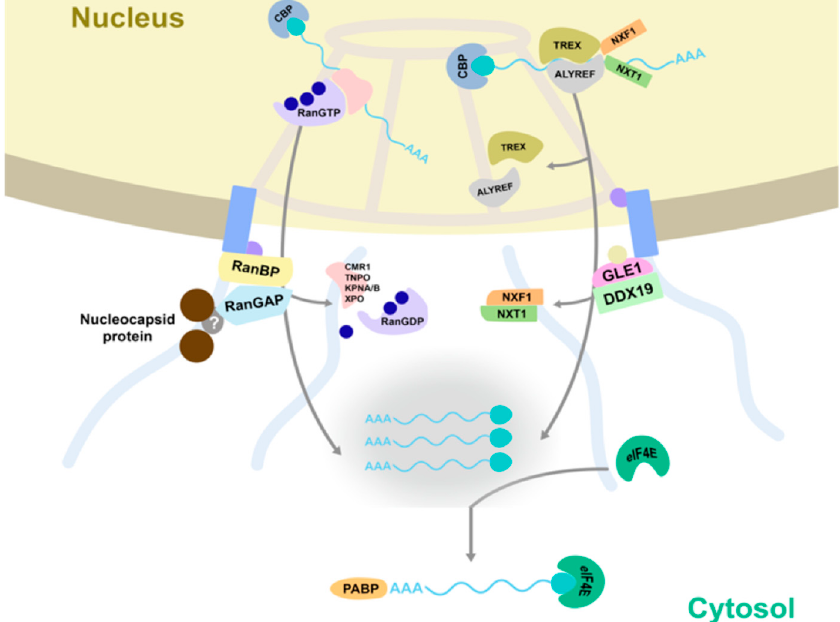
Figure 10. A model for cap snatching at the nucleopore. The interaction of TSWV nucleocapsid (N) protein with RanGAP is indicated. N protein localizes at the nucleopore through interaction with RanGAP and thereby acquires access to the capped RNA molecules involved in RanGAP/RanBP- mediated transportation, and to the mRNA pool (resulting from GLE/DDX19-mediated transporta- tion) in the exclusion zone of the nuclear pore complex at which cap binding protein exchanges with eIF4E, and continues trafficking to the cytosol.